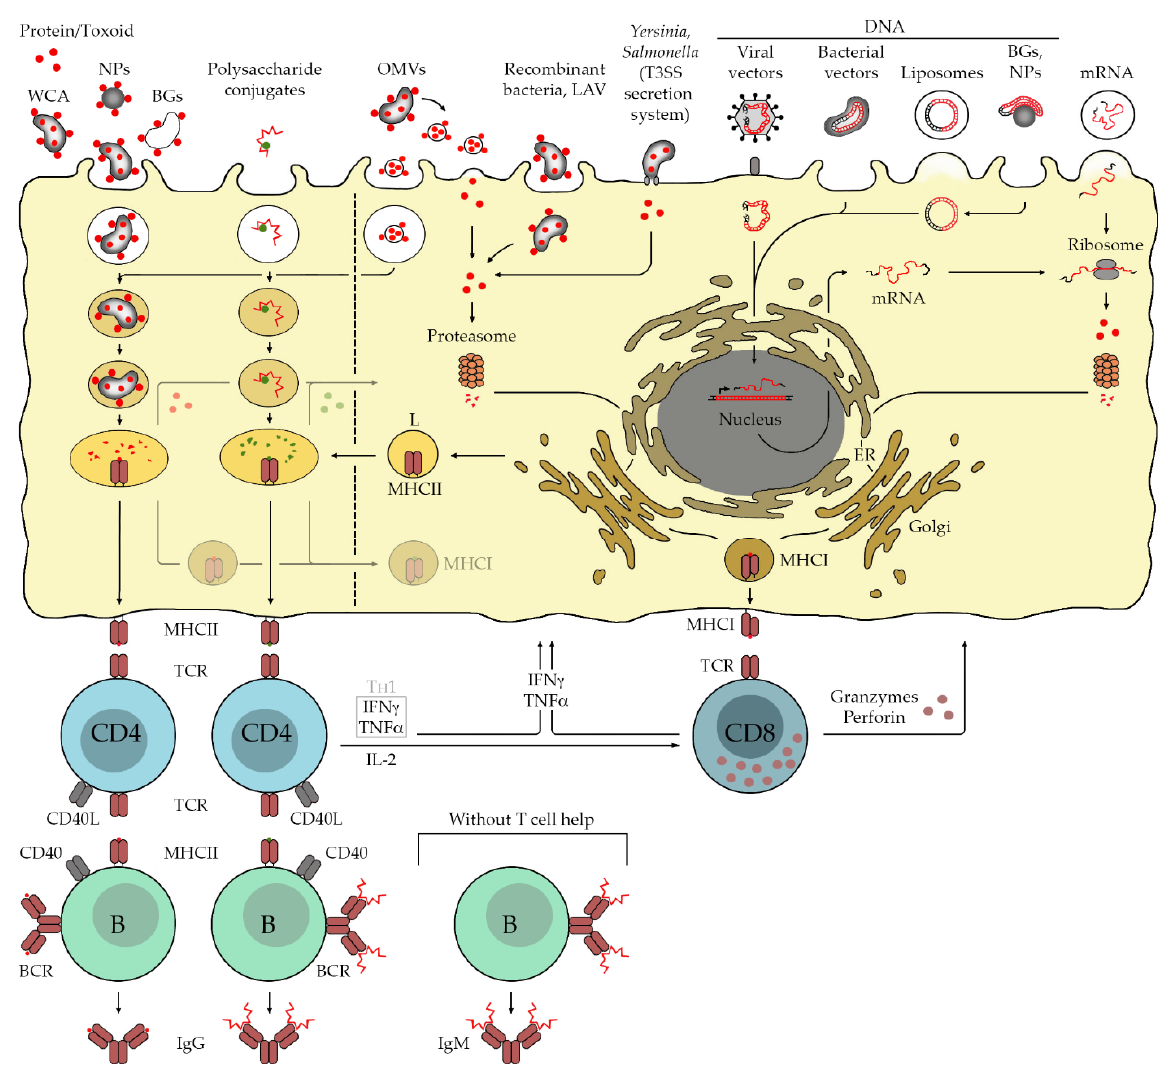
Figure 2. Applied and experimental bacterial vaccines. Today, established bacterial vaccines that are in use are the immunizations with WCA, recombinant proteins including toxoids, polysaccharide/protein conjugates, live attenuated vaccines (LAV), and, since the last few years, also bacterial outer membrane vesicles (OMVs). Vaccination with WCA, bacterial ghosts (BGs), and recombinant proteins/toxoids predominantly results in the processing of protein components for the presentation via MHCII and the activation predominantly of CD4 + T cells. In addition, antigen- specific activated B cells produce high-affinity IgG antibodies with the help of CD4 + T cells, and a memory response is induced. In the case of polysaccharide/protein conjugates, the carrier protein serves as the protein component that can be recognized by CD4 + T cells. This enables B cells to produce high-affinity IgG antibodies against the polysaccharide instead of the production of low- affinity IgM without T cell help. Immunization against intracellular bacterial pathogens requires the activation of cytotoxic CD8 + T cells, which is usually not efficiently achieved with these methods. Antigens recognized by CD8 + T cells predominantly derive from cytosolic proteins that are degraded by the proteasome and further processed for the presentation via MHCI. A major difficulty of efficient vaccination against intracellular bacterial pathogens lies in the introduction of immunogens into the cytosol of host cells. This can be achieved by the use of OMVs, LAV, viral vectors, bacterial vectors, immunization with DNA or mRNA, and the use of the T3SS translocation system of bacteria such as Salmonella . Immunization with OMVs and LAV results in both antigen presentation by MHCII and MHCI molecules for the activation of CD4 + and CD8 + T cells, whereby